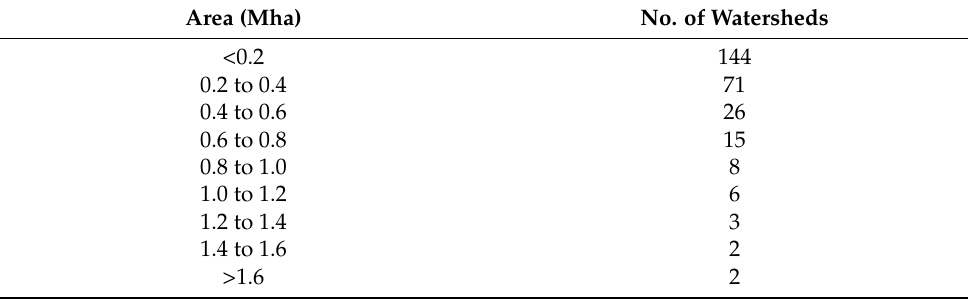
Table 2. Area-wise classification of watersheds in